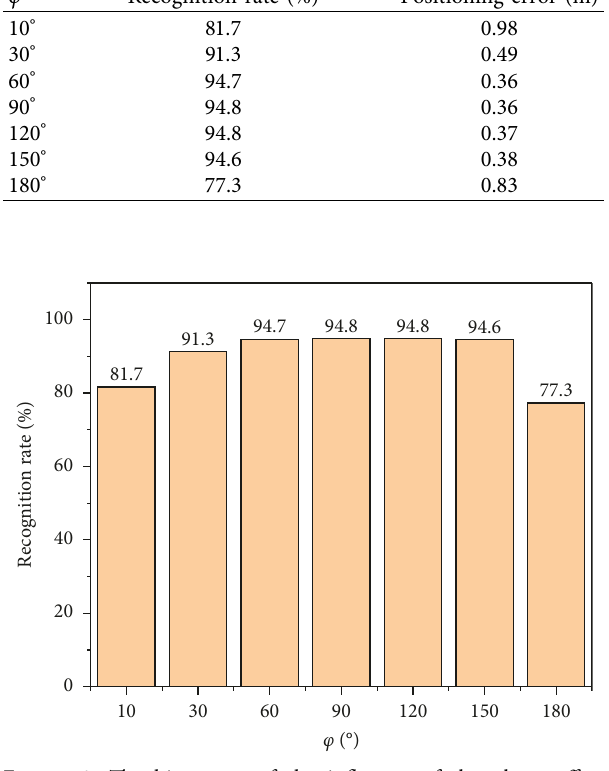
Figure 2: The histogram of the influence of the phase offset threshold φ on the recognition